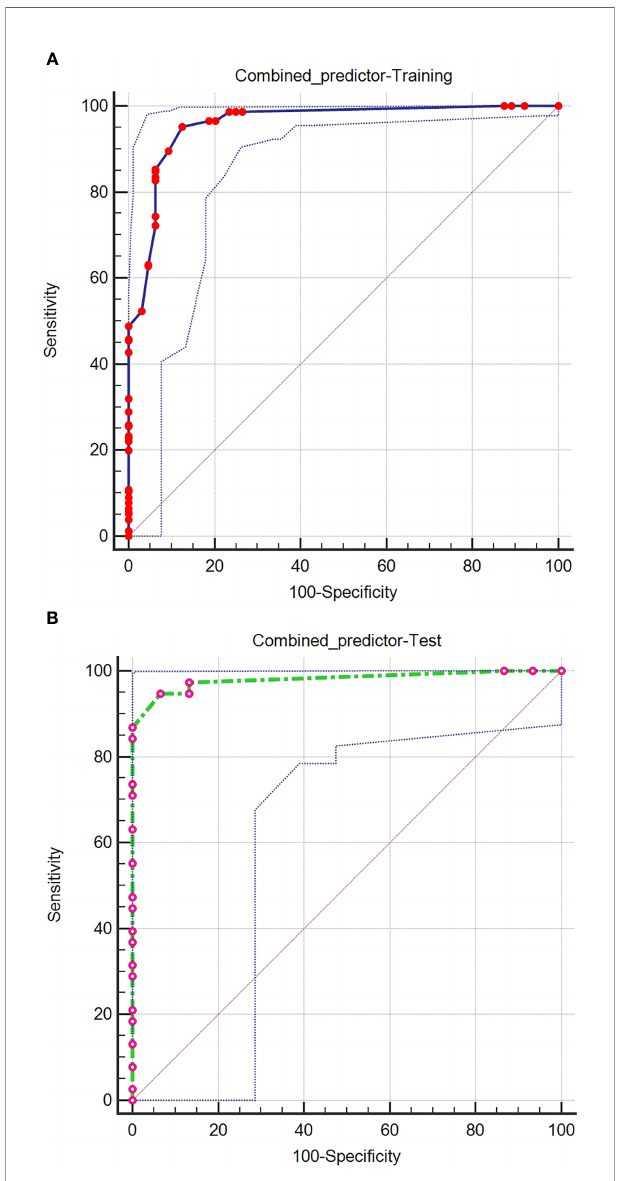
FIGURE 2 | ROC curves of the combined predictors for predicting malignant lesions in the training (A) and test (B) cohorts.